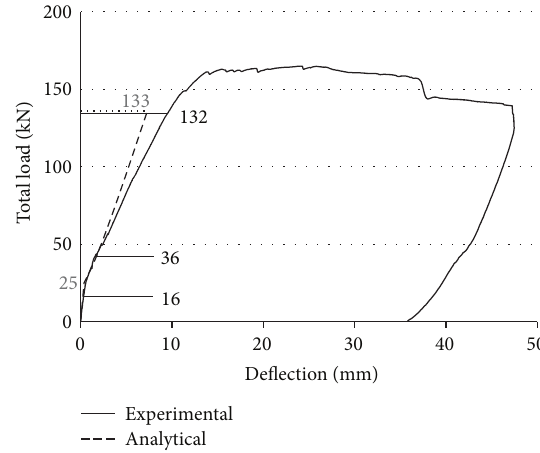
Figure 4: Analytical and experimental load-deflection curves of fully steel reinforced